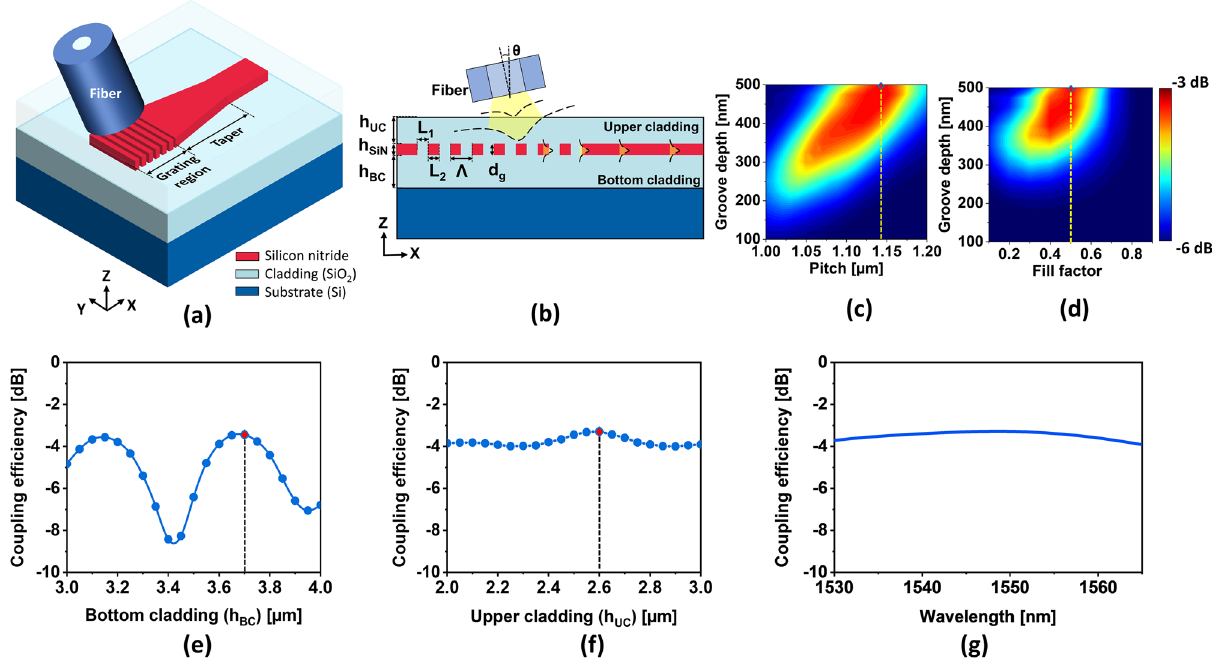
Figure 5. ( a ) Schematic of the proposed GAC and ( b ) its cross-sectional view with the structural parameters labeled. ( c ) Calculated coupling efficiency with respect to the pitch and groove depth. ( d ) Coupling efficiency depending on the fill factor and groove depth. Coupling efficiency as function of ( e ) the bottom and ( f ) upper cladding. ( g ) Spectral coupling response under the specified design of light from the fiber to the waveguide, its parameters were fastidiously derived. A cross-sectional view of the GAC is shown in Fig. 5b. The gratings were created by inscribing an array of grooves over a distance L 1 according to a depth of d g , in a strip waveguide with a thickness of h SiN = 500 nm. The fill factor of the grating is defined as the ratio of the uninscribed waveguide length (L 2 ) to the total grating pitch (Λ). For an incident angle (θ) of 13°, the grating pitch is estimated using the Bragg’s condition to be approximately 1.15 µm for the fully inscribed condition with groove depth (d g ) of 500 nm at (cid:31) c = 1550 nm. FDTD simulations were executed to probe the dependence of the total coupling efficiency on the structural parameters. Figures 5c,d show the calculated coupling efficiencies with respect to the groove depth, pitch, and fill factor of the GAC. The GAC is observed to achieve the maximum efficiency when d g , Λ, and f are 500 nm, 1.14 µm, and 0.5, respectively. Noting the thicknesses of the upper cladding (h UC ) and bottom cladding (h BC ) affect the coupling efficiency 11,12 , simula- tions were carried out by varying h UC and h BC , as shown in Fig. 5e,f, respectively. The maximum efficiency was obtained for h UC = 3.7 µm and h BC = 2.6 µm. The GAC was simulated to discover the throughput from the fiber to the waveguide using the specified parameters, as presented in Fig. 5g. The observed throughput was − 3.2 dB at λ = 1550 nm and remained beyond − 3.9 dB throughout the C-band. For end-fire coupling, an SSC was suggested to deliver light from the fiber to the waveguide. The SSC incor- porated a multi-stage taper which could expand the guided mode profile of the waveguide to match that of the fiber. Here, the SSC was designed in line with an ultra-high numerical aperture fiber exhibiting a tiny mode field diameter of ~ 4 µm, whose splicing loss relating to a standard single mode (SMF28) fiber was known to be as small as 0.06 dB 24 . As shown in Fig. 6a, the SSC is based on a 500-nm thick SiN multi-stage taper linked to a 750-nm wide output waveguide. The thicknesses of the upper and the bottom cladding were chosen to be 2.6 µm and 3.7 µm, as per the GAC design. As for the taper, the mode overlap between the fundamental TE mode of the fiber and that of the tip of the taper was estimated. The TE mode field profiles of the fiber and the 200-nm wide tip waveguide are depicted in Fig. 6b-(i) and (ii), respectively. The mode overlap integral 25 was scanned in terms of the taper tip width, as plotted in Fig. 6c, signifying that a tip width of 200 nm lead to an approximate maximum overlap of 0.94. Hence, a tip width of 200 nm was selected for the SSC. Rather than exploiting a sin- gle adiabatic taper, typically measuring several hundred micrometers in length, a shortened multi-stage taper drawing upon three serially concatenated taper segments was adopted 13 . As delineated in Fig. 6d, the proposed taper has a total length of 65 µm. Figure 6e shows the spectral response of the SSC coupling efficiency, signaling the SSC could deliver a coupling efficiency better than − 0.5 dB throughout the C-band. In order to enhance the tolerance in terms of dicing and polishing processes during practical device manufacturing, the SSC can take advantage of a short length of elongated tip waveguide, whose width is in the vicinity of 200 nm, as demonstrated in our previous work 13 .